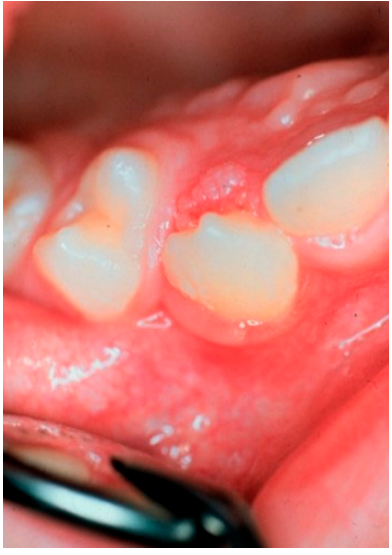
Figure 3. HPV11-positive oral papilloma of a